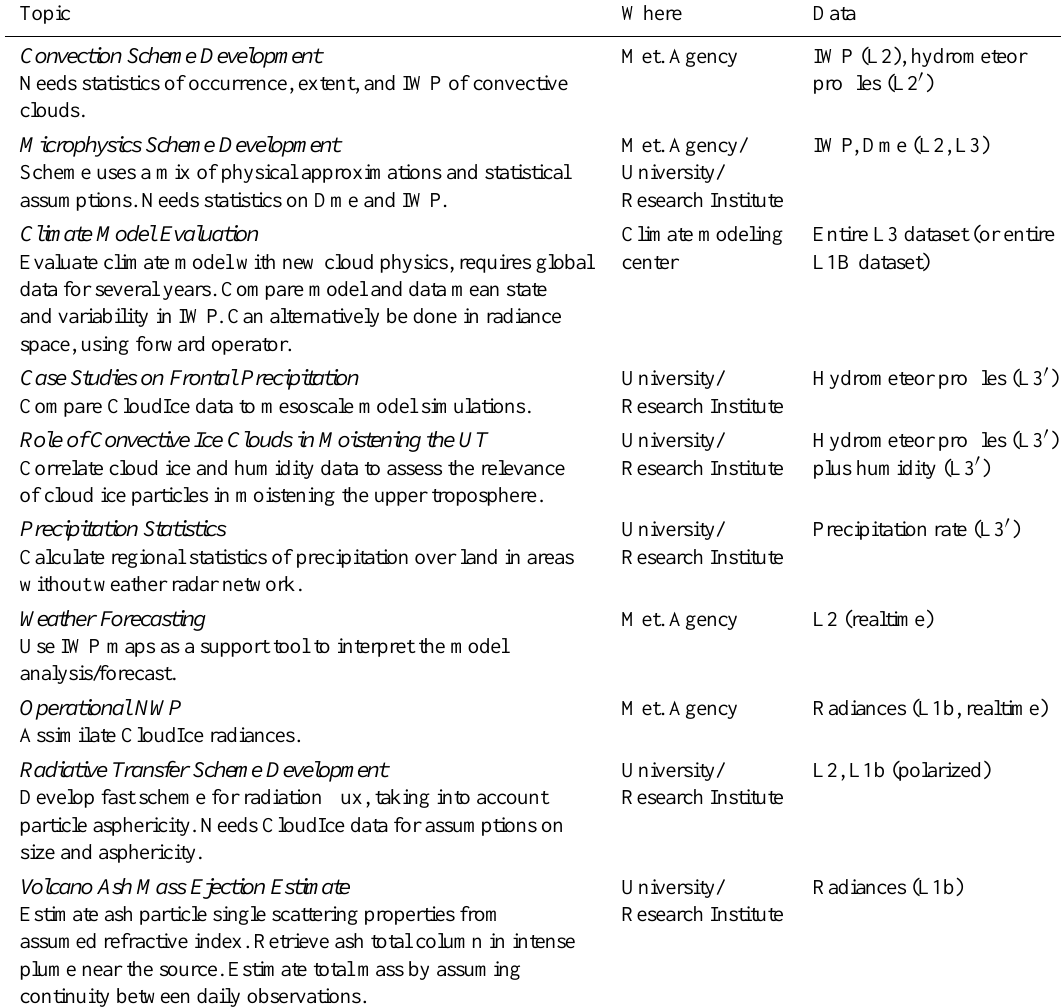
Table 7. Example use cases for CloudIce